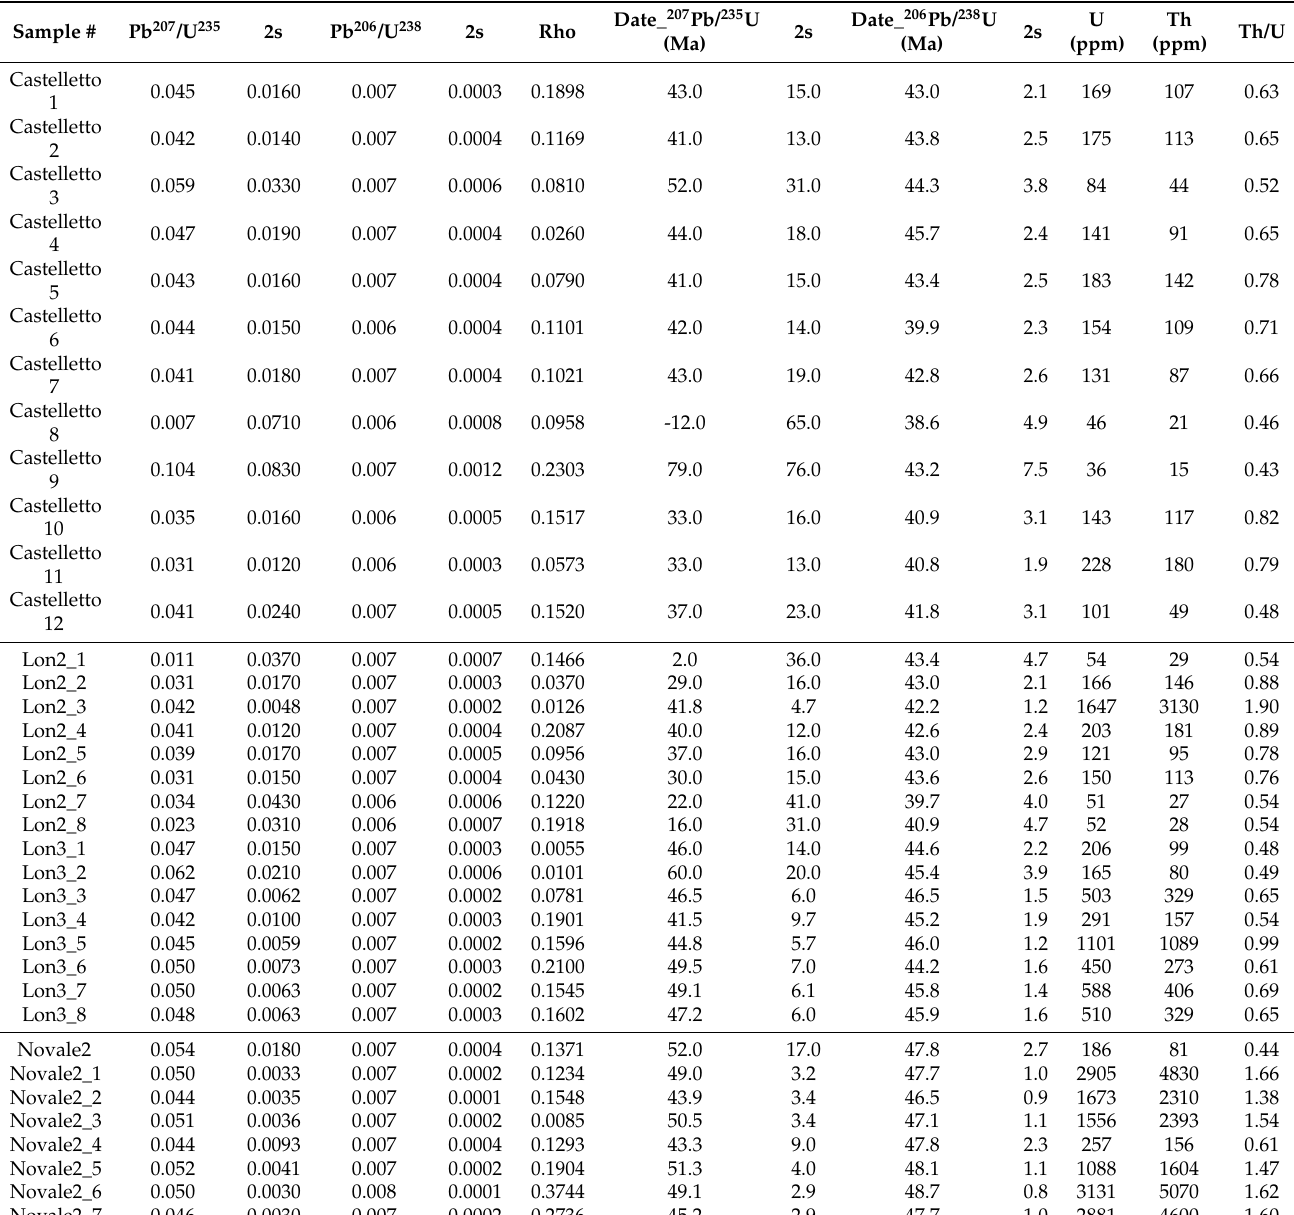
Table 6. Results of U–Pb age calculation. Rho: error correlation of 207 Pb/ 235 U and 206 Pb/ 238 U defined